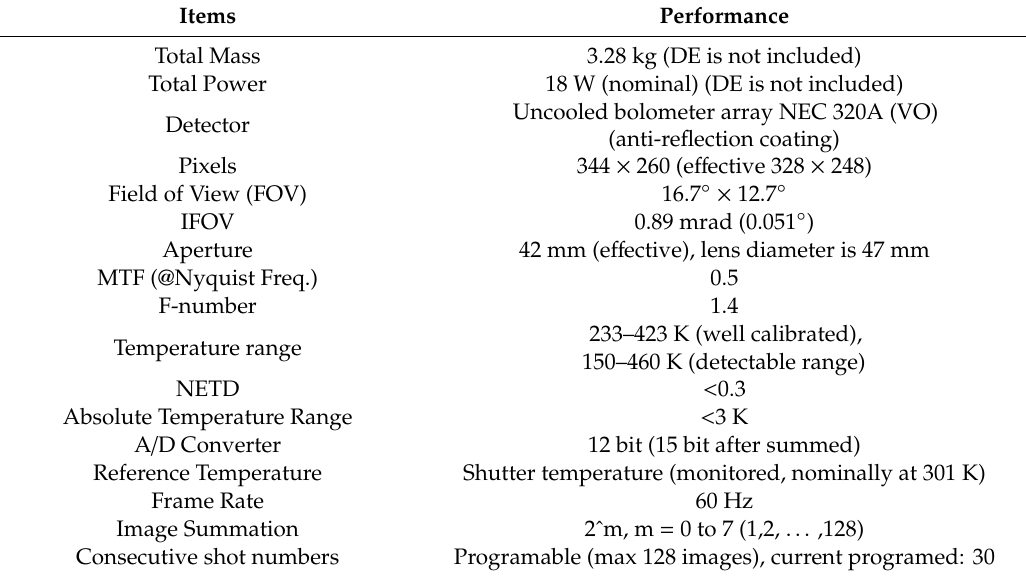
Figure 1. The flight model of the sensor unit of the thermal infrared imager TIR onboard Hayabusa2 (TIR-S). White squares on the sensor case are the Velcro tapes to attach the multi-layer insulators (MLI, the thermal blankets, not shown) which cover the sensor unit to stabilize the temperature during the operation. A baffled sunshade (not shown) is attached in front of the germanium lens to avoid insolation. The aperture of the lens is 42 mm in diameter (diameter of lens is 47 mm), and the stepping motor for the mechanical shutter is seen at the right hand of the lens. The sheet heater around the lens case is to adjust the temperature of the optics. The scale on the name plate is 10 cm long (1 cm each). (© Japan Aerospace Exploration Agency (JAXA)). Table 1. Characteristic performance of TIR on Hayabusa2 [1].